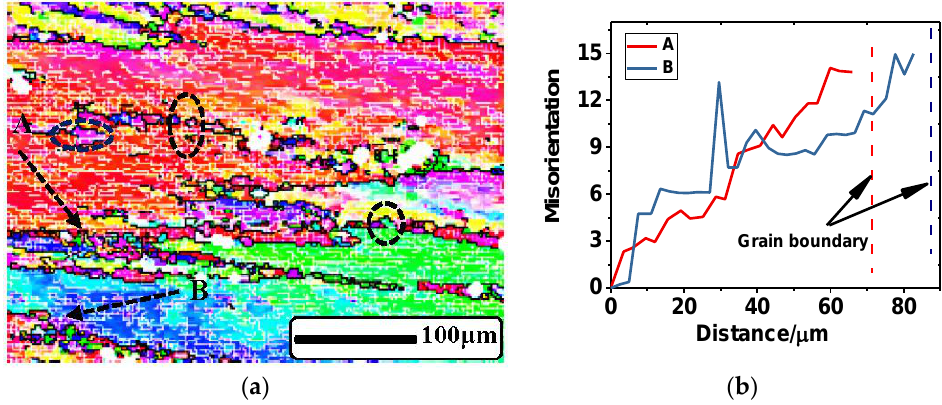
Figure 9. EBSD measurement showing continuous dynamic recrystallization (CDRX) in 2219Al alloy. ( a ) Micrograph of the deformed sample under the condition of 673 K and 10 s − 1 ; ( b ) the cumulative misorientation along the dotted line from A and B to the grain